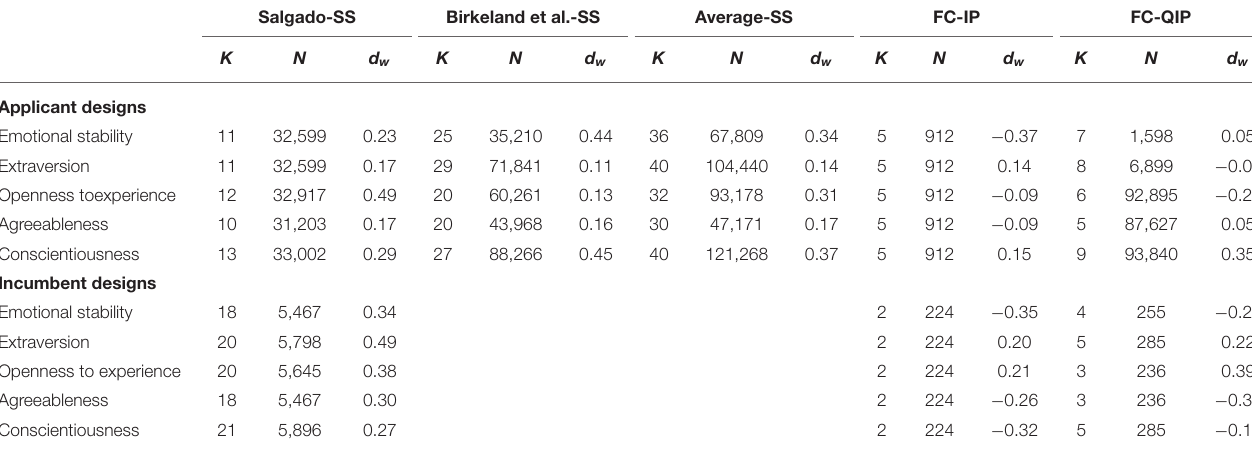
TABLE 7 | Comparison between the meta-analyses of the resistance of faking of FC and SS personality inventories in applied contexts.